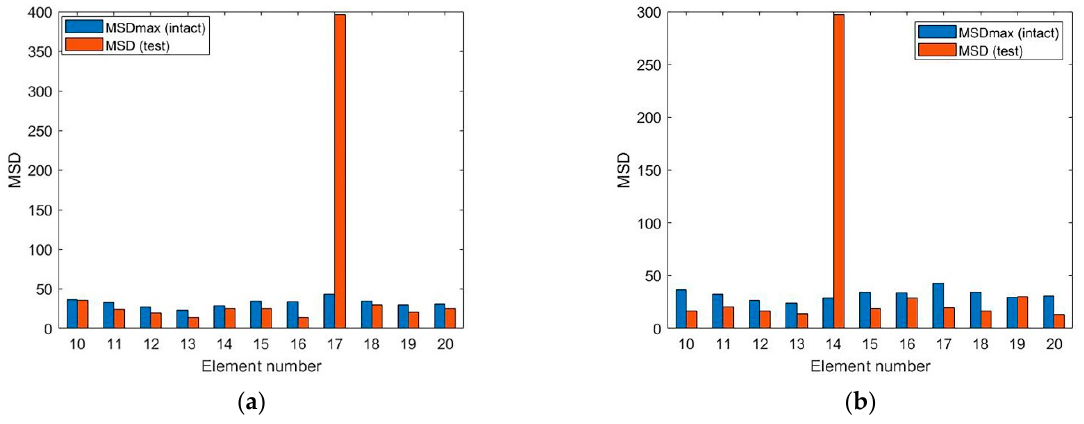
Figure 4. ( a ) Single-damage of the 17th element under El-Centro earthquake; ( b ) single-damage of the 14th element under Chi-Chi earthquake.